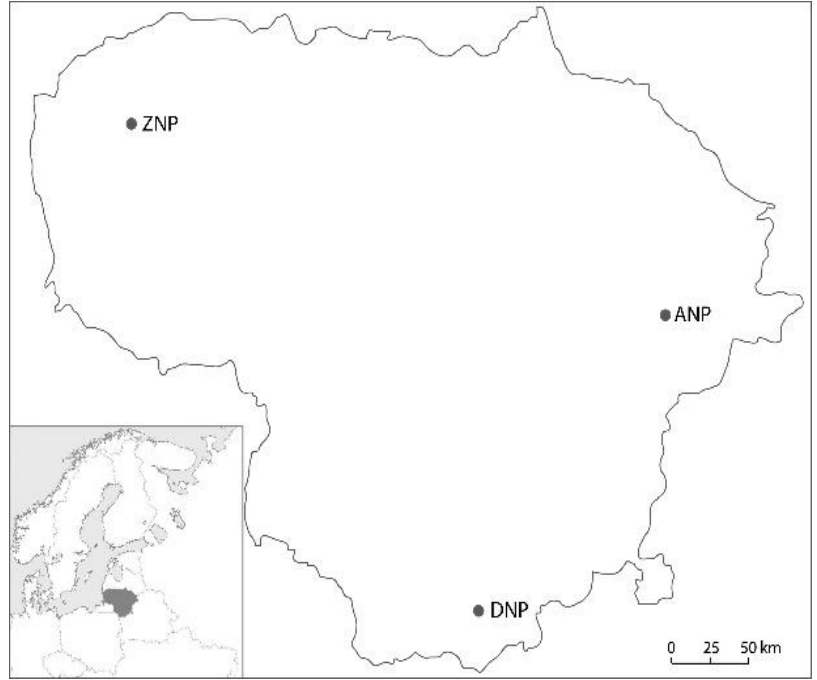
Figure 1. Map of Lithuania (position shown by shading on the north European map in the lower left corner) showing principal locations of the Aukštaitija national park (ANP), Dzūkija national park (DNP) and Žemaitija national park (ZNP), where sampling of living needles and soil was carried out in managed and unmanaged Pinus sylvestris forest stands.